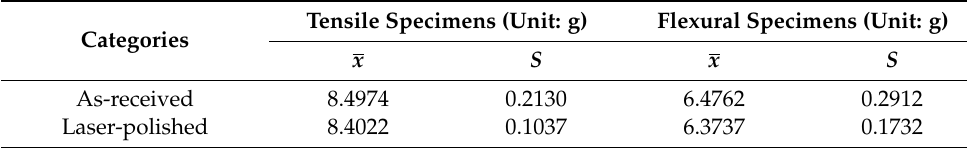
Table 5. The average value and standard deviation of the tensile and flexural specimens.